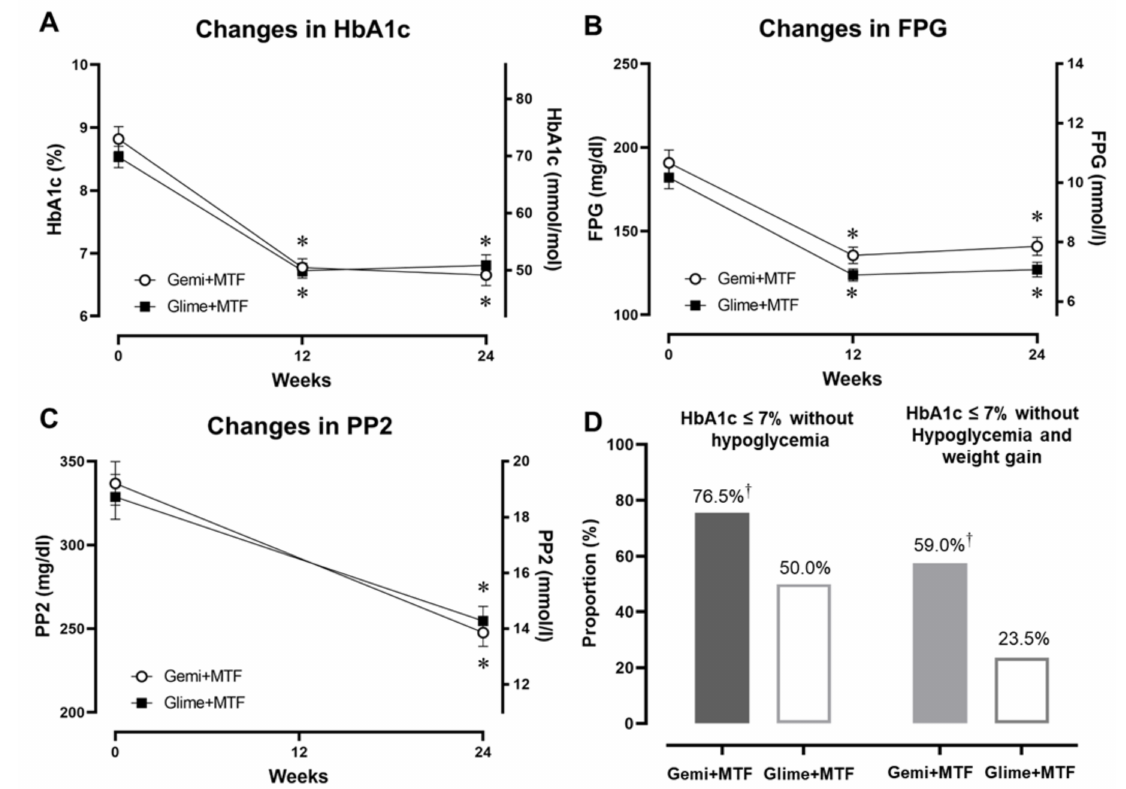
Figure 1. Changes in glycemic parameters after gemigliptin–metformin or glimepiride–metformin combination therapies during the study period, and the proportion of participants who achieved the glycemic target of HbA1c ≤ 7.0% (53 mmol/mol) without hypoglycemia or weight gain. ( A ) HbA1c (%), ( B ) FPG, fasting plasma glucose concentration, ( C ) PP2 (postprandial 2-h glucose concentration), and ( D ) proportion of participants within the glycemic target without hypoglycemia (left) and without hypoglycemia and weight gain (right). * p < 0.05 from the baseline, † p < 0.05 between the